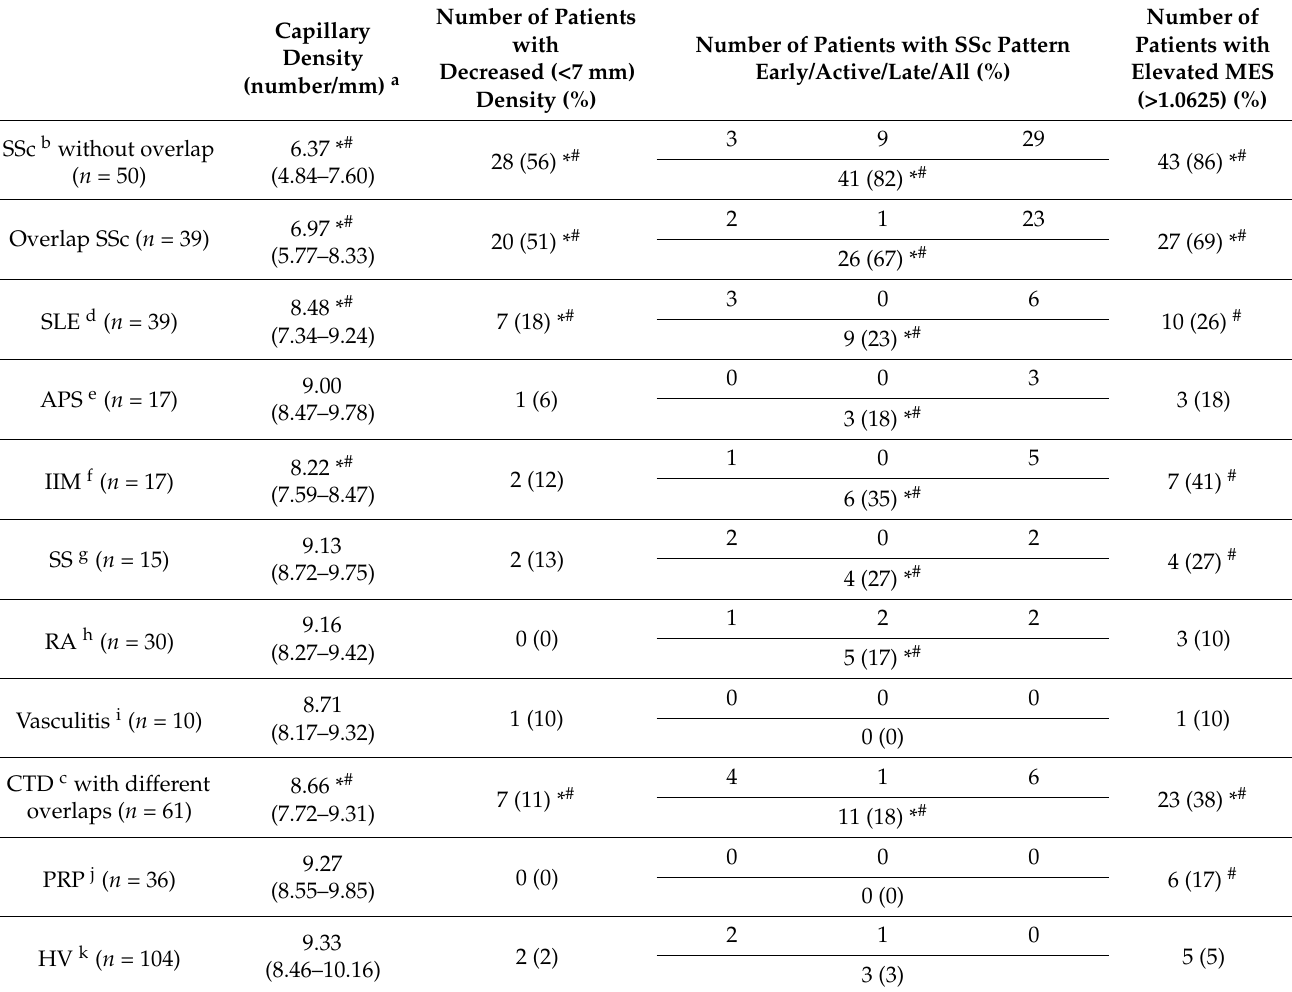
Table 2. Capillaroscopic parameters in the different groups of